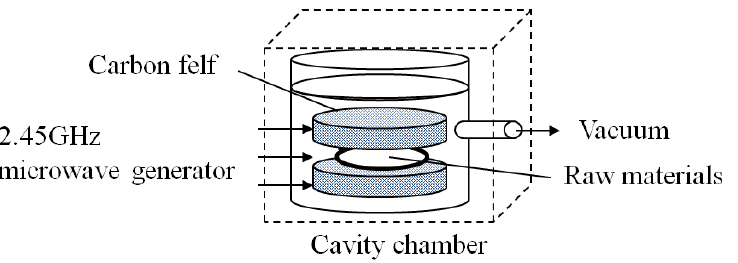
Figure 1. Schematic diagram of carbon felt and a 2.45 GHz microwave generator